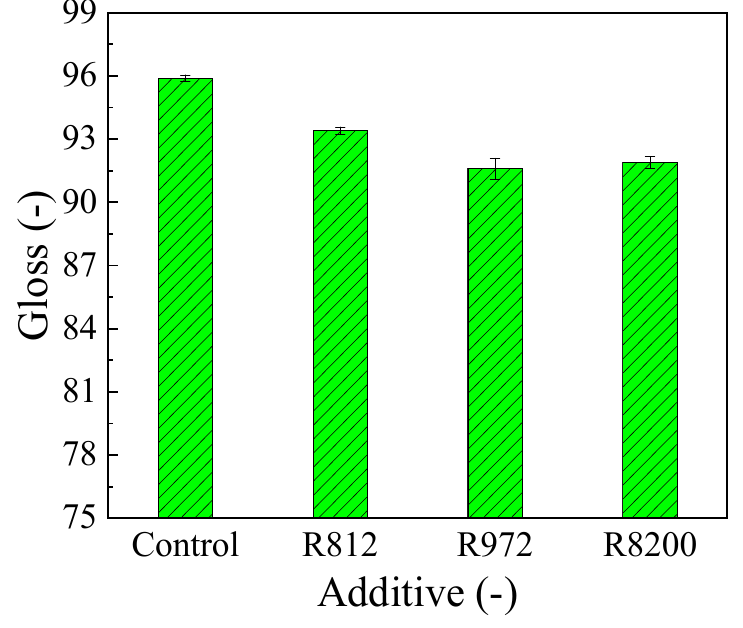
Figure 11. Gloss of powder samples films.